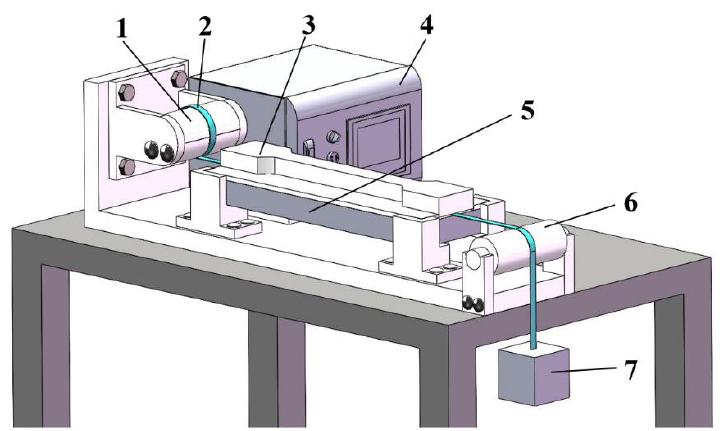
Figure 2. A bespoke creep stress-based fibre prestressing rig showing (1) fibre fixing clamp; (2) uni- directional fibre prepreg material; (3) upper mould; (4) and (5) heating module with a temperature accuracy of ±1 °C; (6) roller; and (7) weight platform.